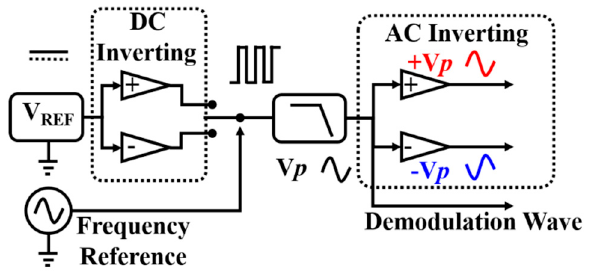
Figure 4. The block diagram of carrier wave production, consisting of voltage reference, switch, filter, inverting circuit, and frequency reference.